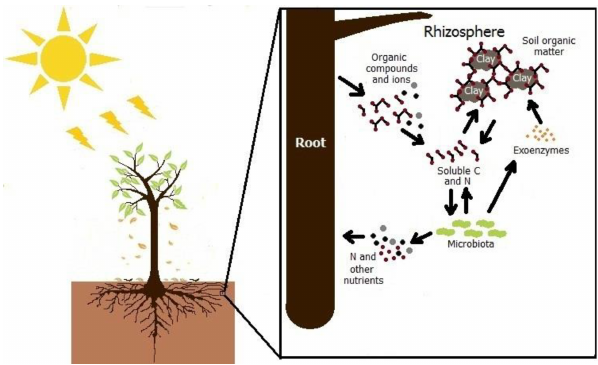
Figure 1. Illustration of rhizosphere C and N cycling processes in the ForPRAN